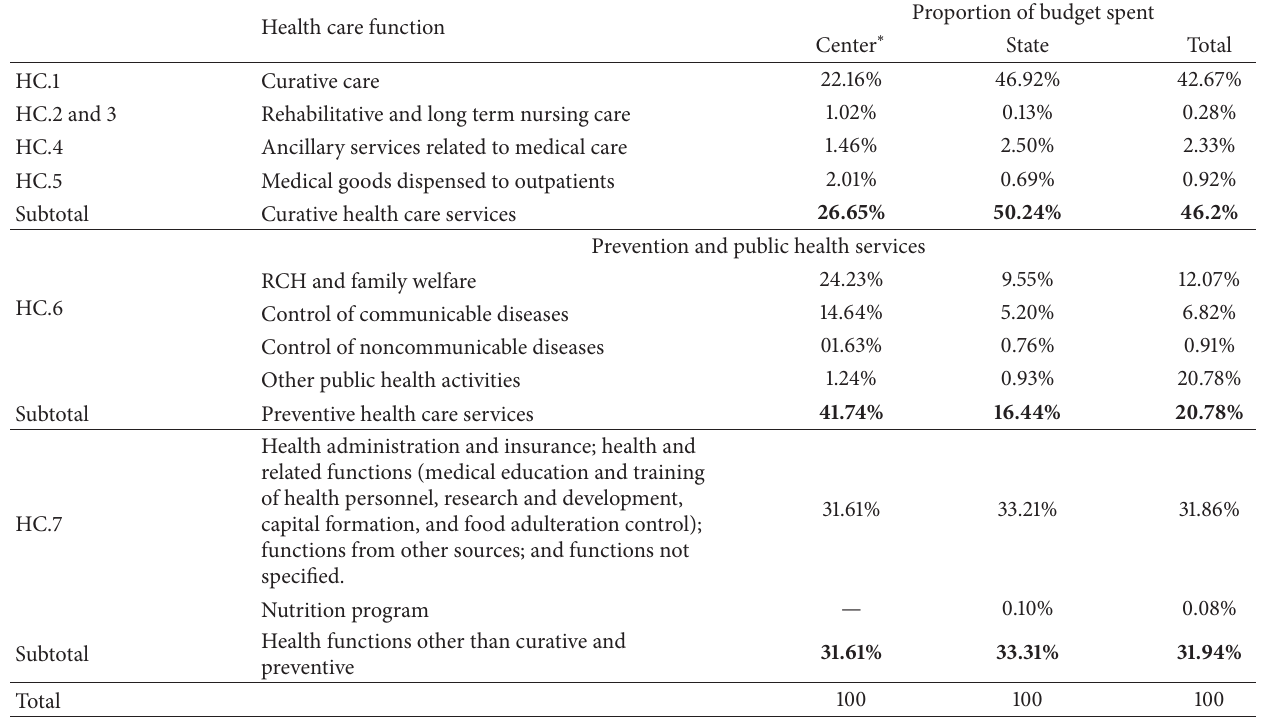
Table 14: Health expenditure by ICHA functions, National Health Accounts,